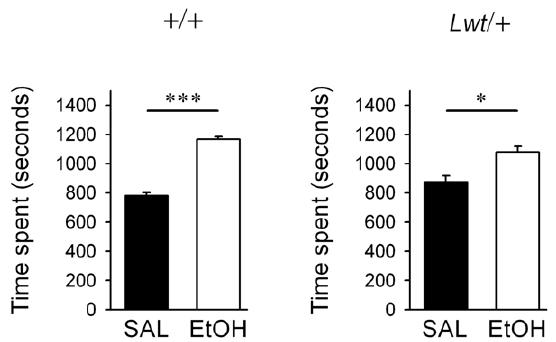
Figure 9. Lwt / + congenic mice develop a conditioned place preference to ethanol. Wild-type (n= 11) and Lwt / + (n=11) littermates developed a conditioned place preference to a 1.75 g/kg dose of ethanol. (* P , 0.05; *** P , 0.001 compared with